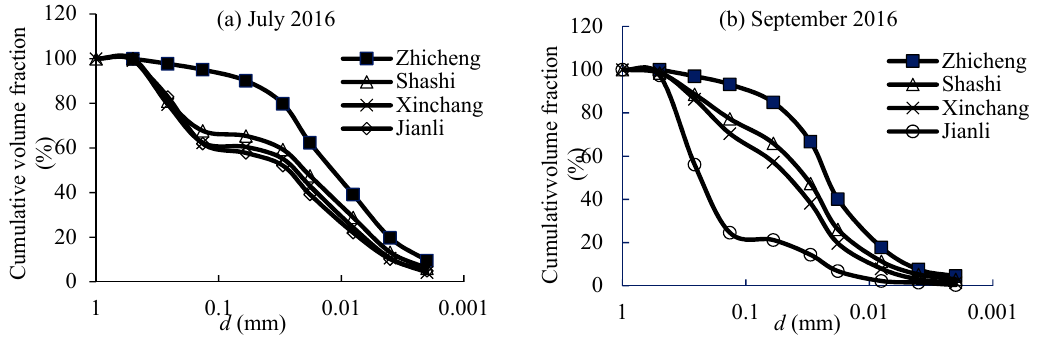
Figure 9. Cumulative volume fractions of suspended sediment at 2016: ( a ) measured in July 2016 and ( b ) data measured in September 2016.